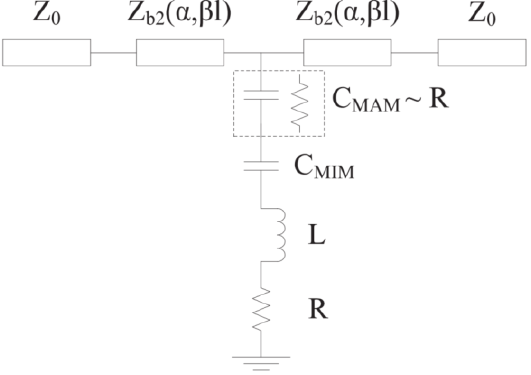
Figure 4. The relationship between g , t d and C r .